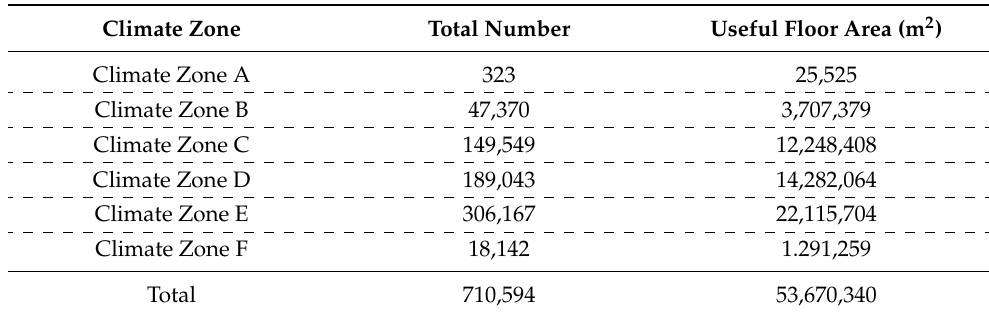
Table 3. Summary of buildings for social housing and their floor area divided based on climate zone